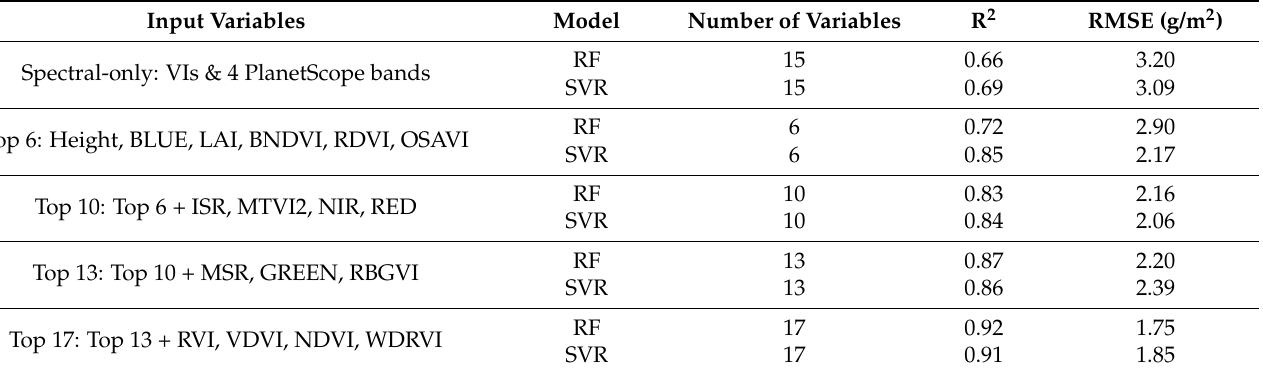
Table 12. Statistics for the validation of the PlanetScope canopy nitrogen model with 12, 20, and 27 May data and different combinations of variables ( n = 44) 1